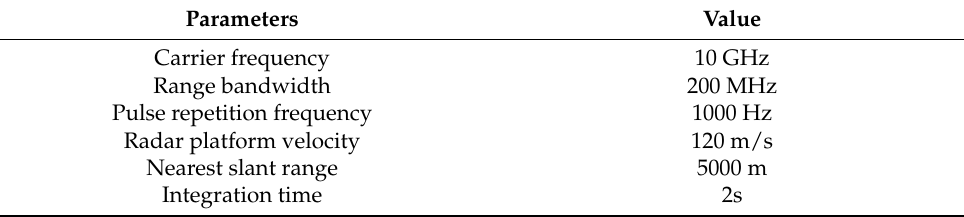
Table 1. Basic parameters of simulation radar.